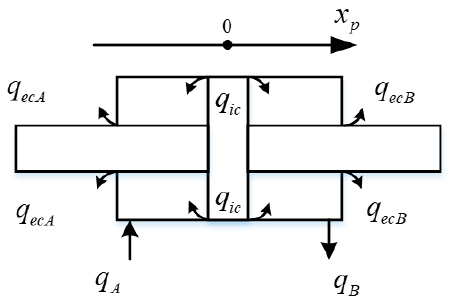
Figure 3. Hydraulic pump flow distribution.